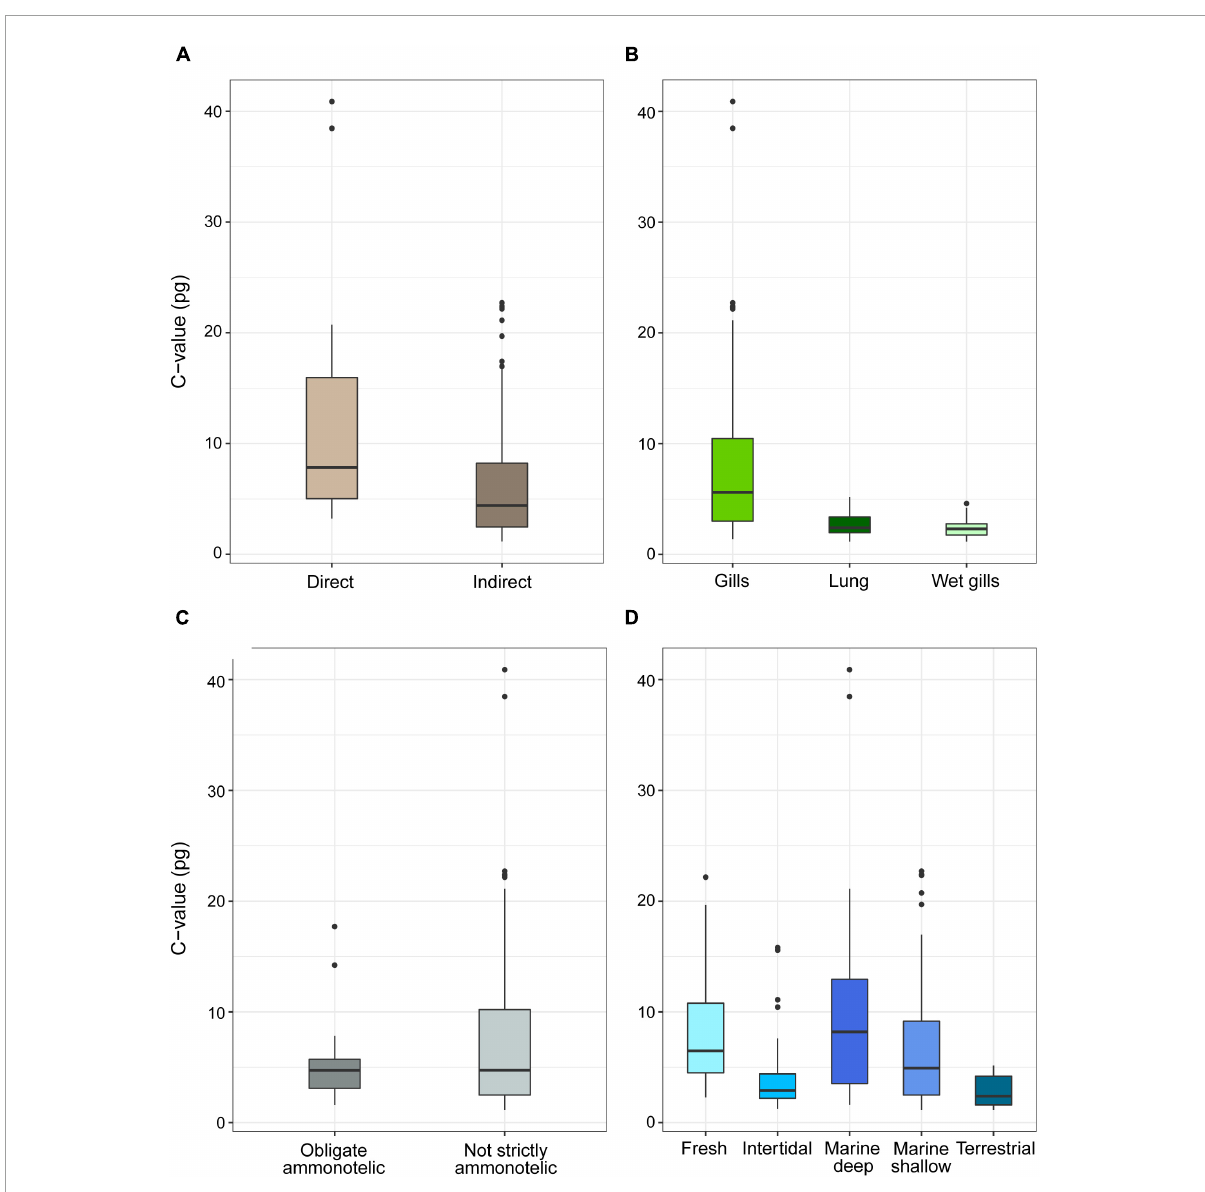
FIGURE3 Genome size (pg, uncorrected values) in species of decapods grouped according to developmental (A) , respiration (B) , excretion (C) mode, and habitat (D) . The boxplots whiskers indicate the 95% confidence intervals and the dots indicate the